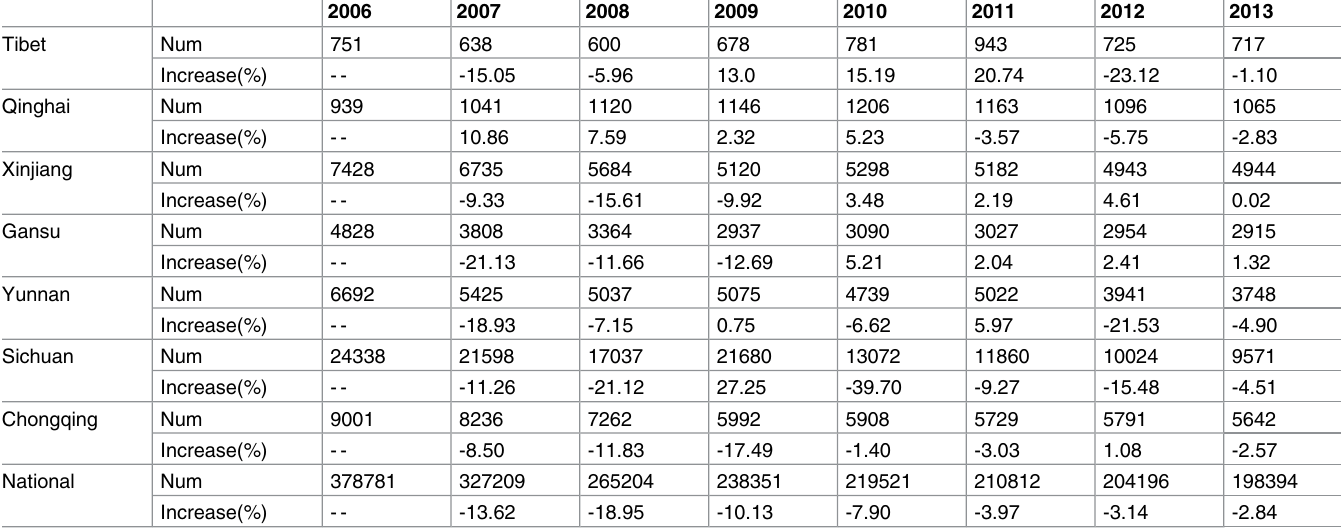
Table 5. Road traffic accidents from 2006to 2013 in the high altitude provinces and nationally in